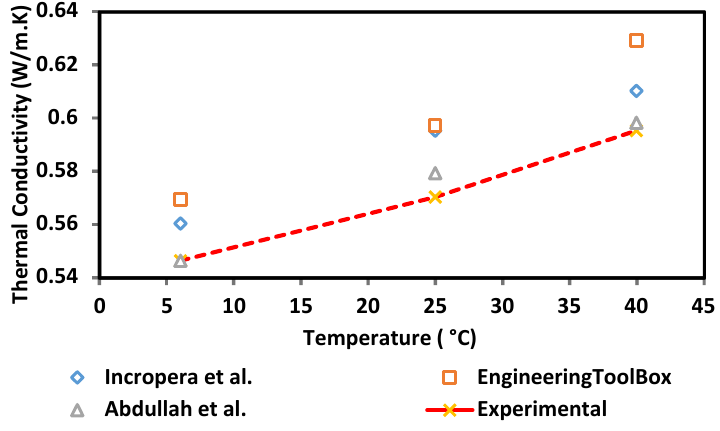
Figure 3. Comparison of thermal conductivity validation between experimental and reference values.